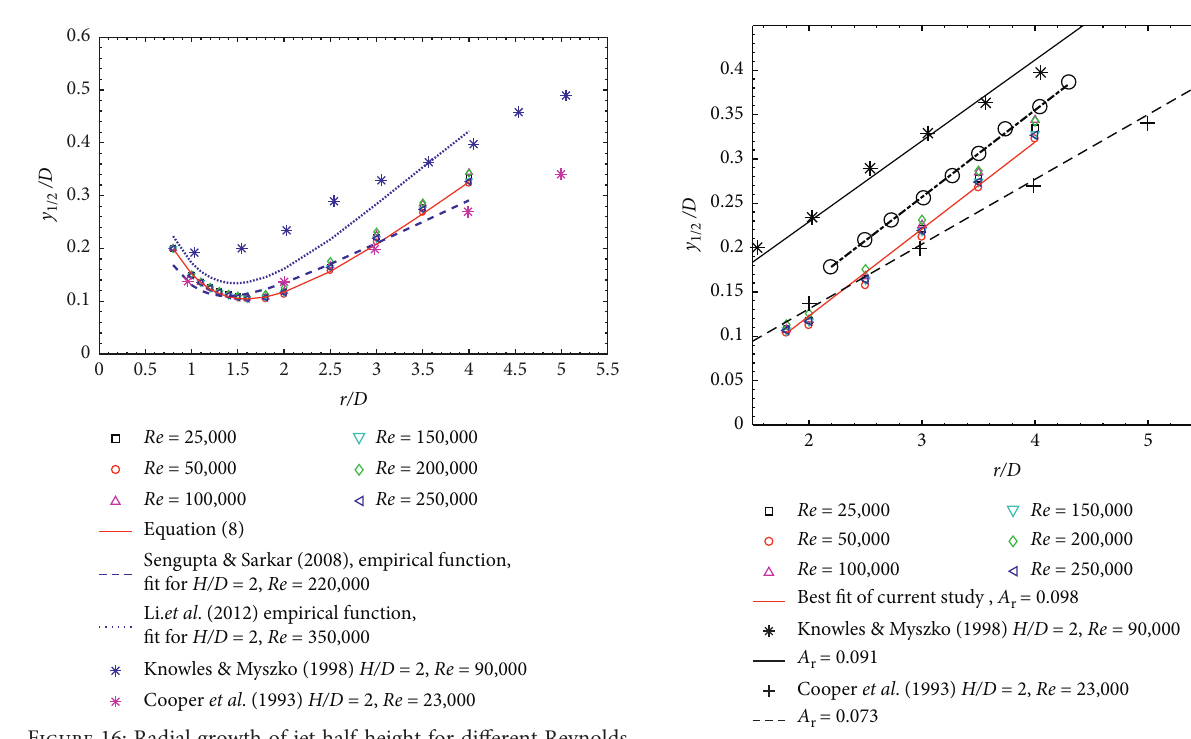
Figure 16: Radial growth of jet half-height for different Reynolds numbers.